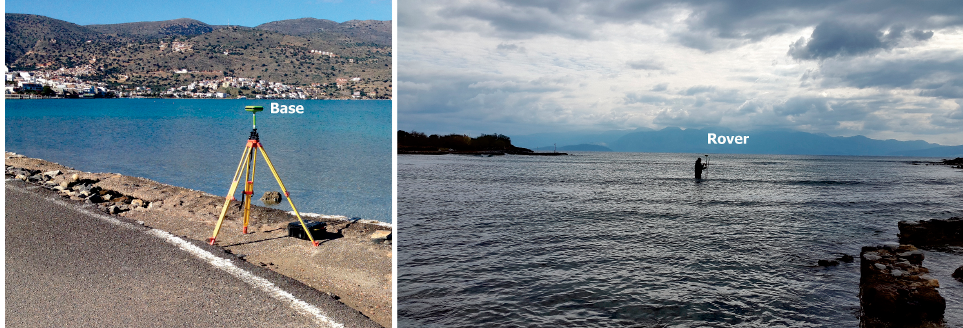
Figure 2. Base and rover Global Navigation Satellite System (GNSS) units used in the topographic mapping of Olous.